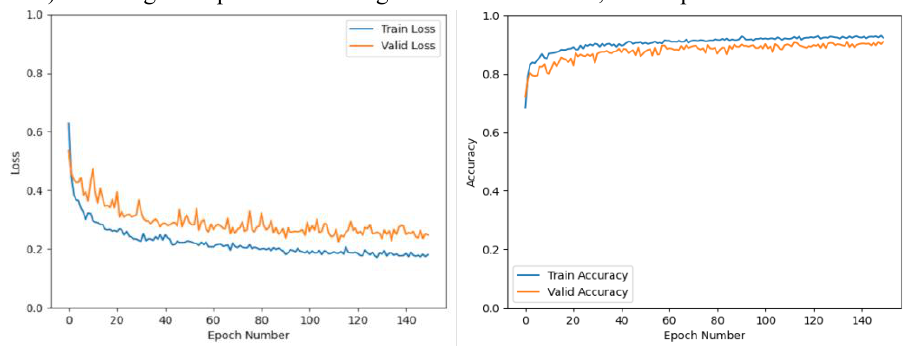
Fig. 2. Loss curve and Acc curve.